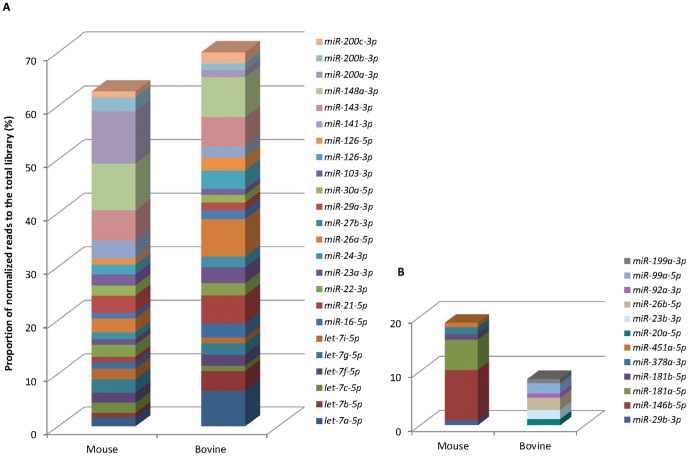
The top 30 most highly expressed miRNA in mouse and bovine lactating mammary glands.Representation of the percentage of normalised reads in the total library of the 24 miRNA common to the mouse and bovine species (A) and of the six miRNA present in only one species (B).